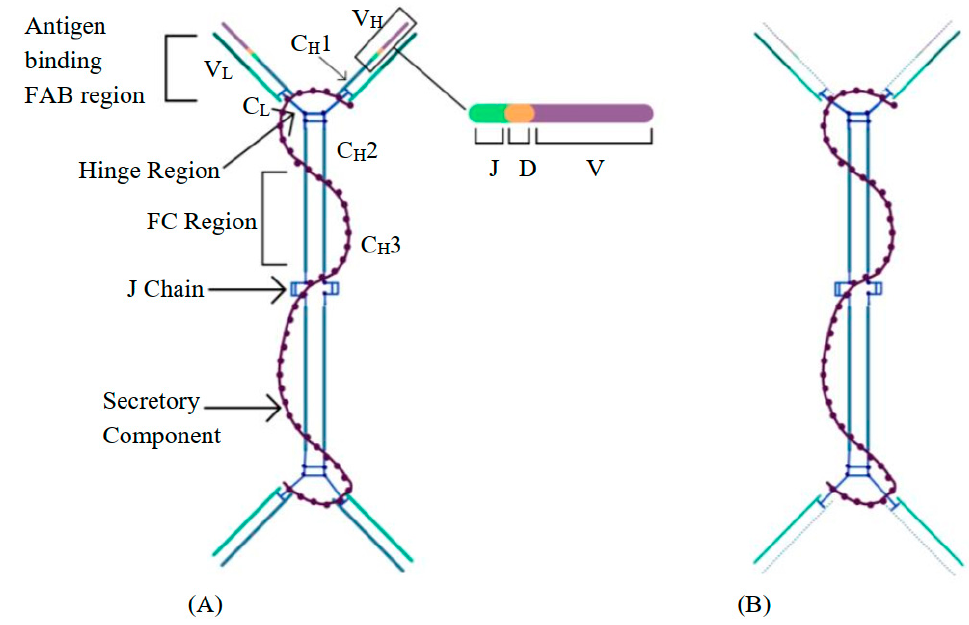
Figure 2. ( A ) Normal IgA structure. ( B ) Aberrant IgA molecule with missing V H and C H 1